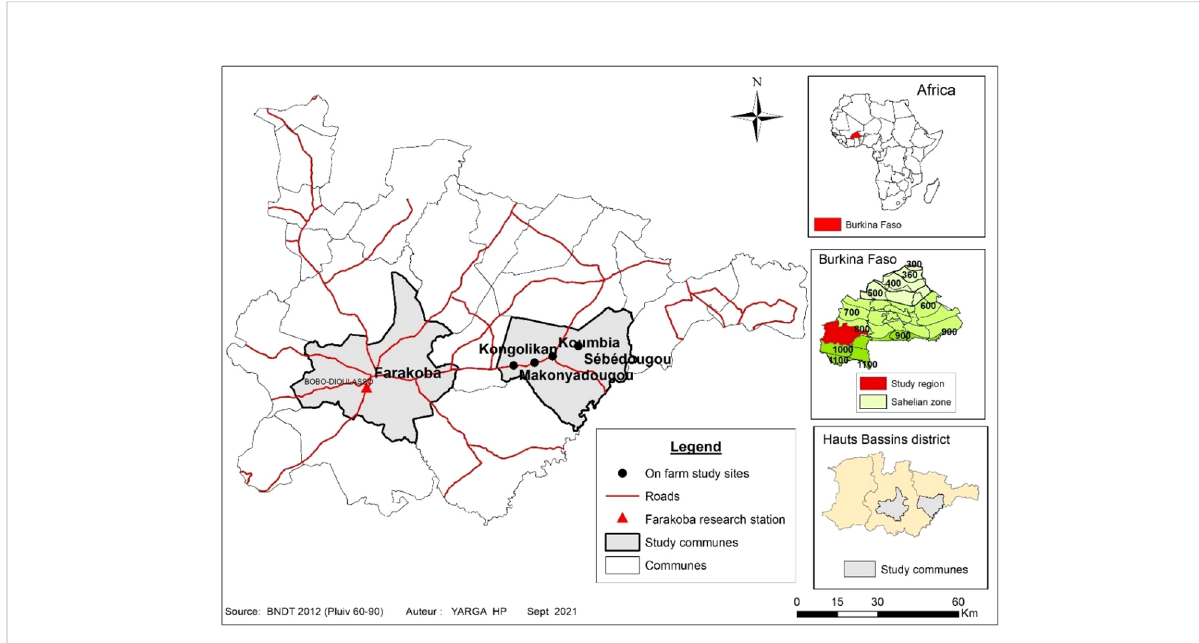
FIGURE 1 Map of the study location in Burkina